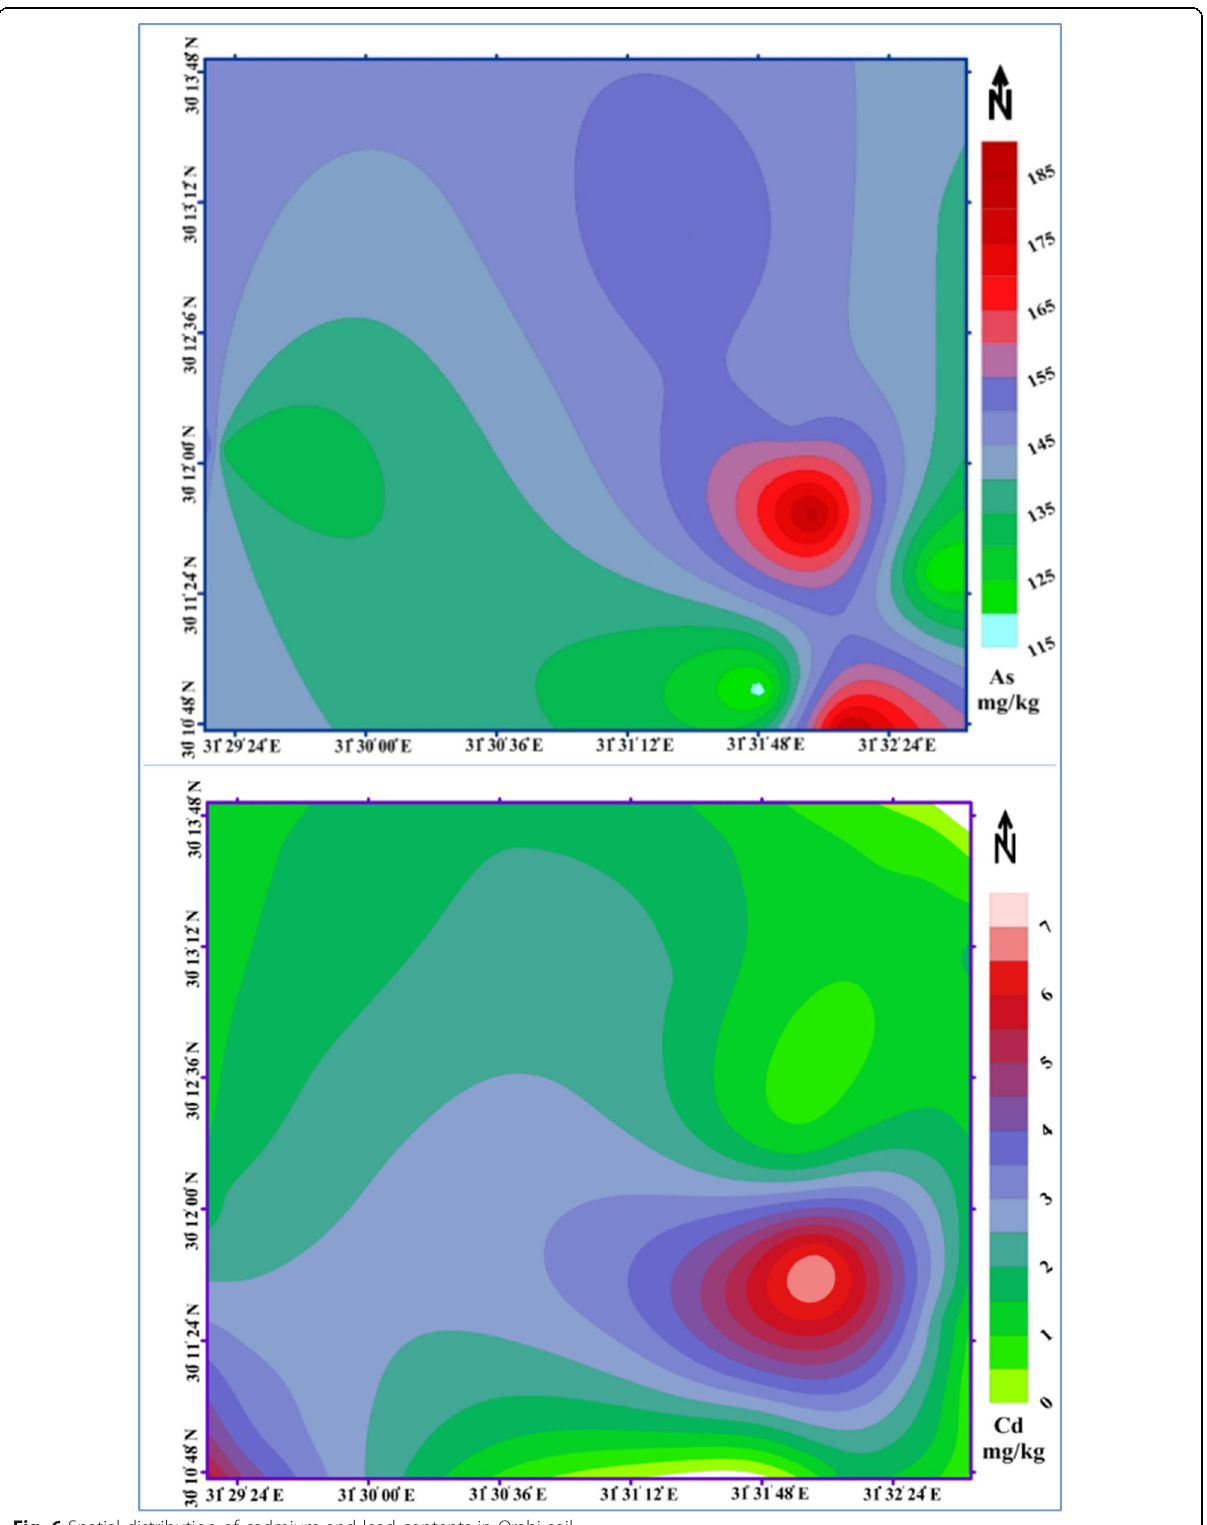
Fig. 6 Spatial distribution of cadmium and lead contents in Orabi